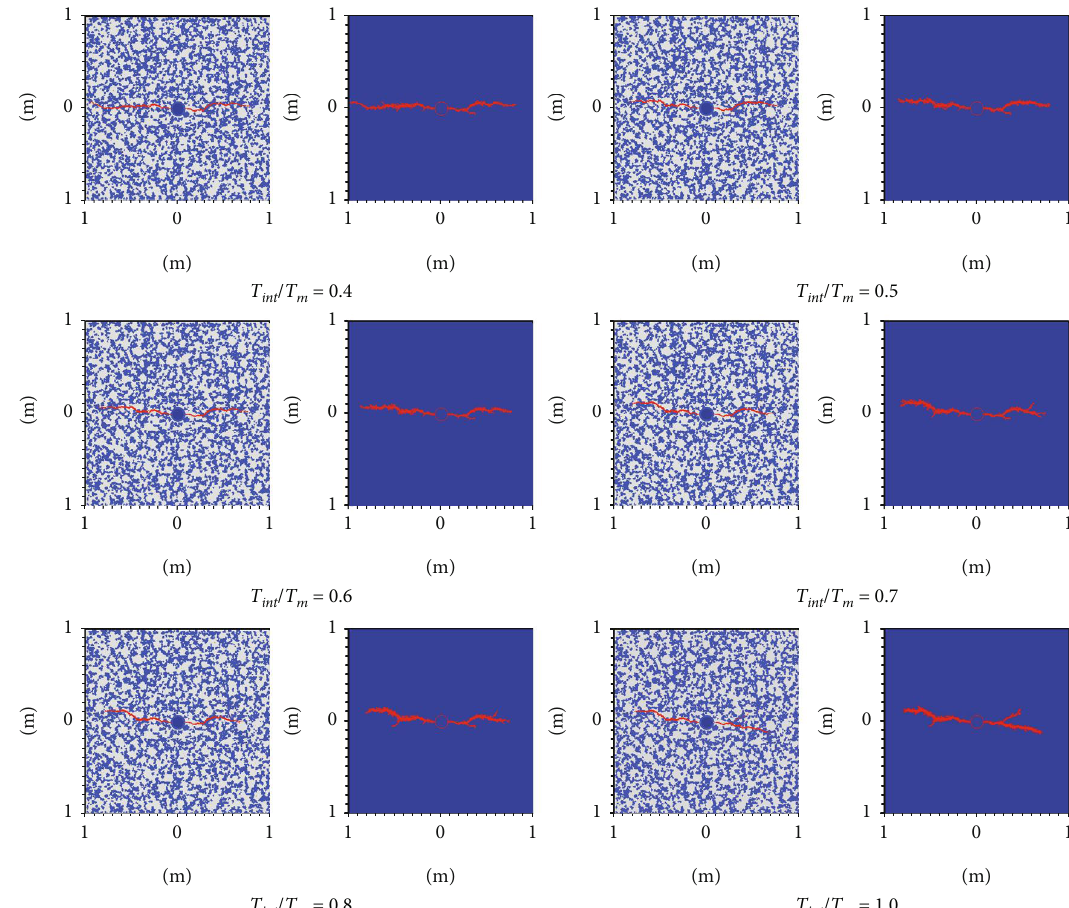
Figure 15: HF propagation morphology under di ff erent ratios of matrix-gravel interface tensile strength to